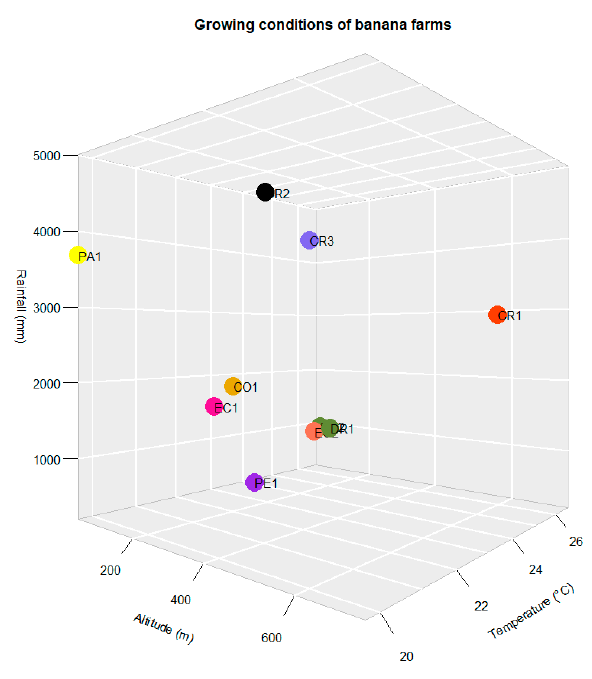
Figure 2. Differences in geographical factors of banana farms from Colombia (CO), Costa Rica (CR), Dominican Republic (DR), Ecuador (EC), Panama (PA), and Peru (PE). The numbers refer to individual farms in a country (please refer to the web version of this article for the interpretation of the colors used in the figure.).